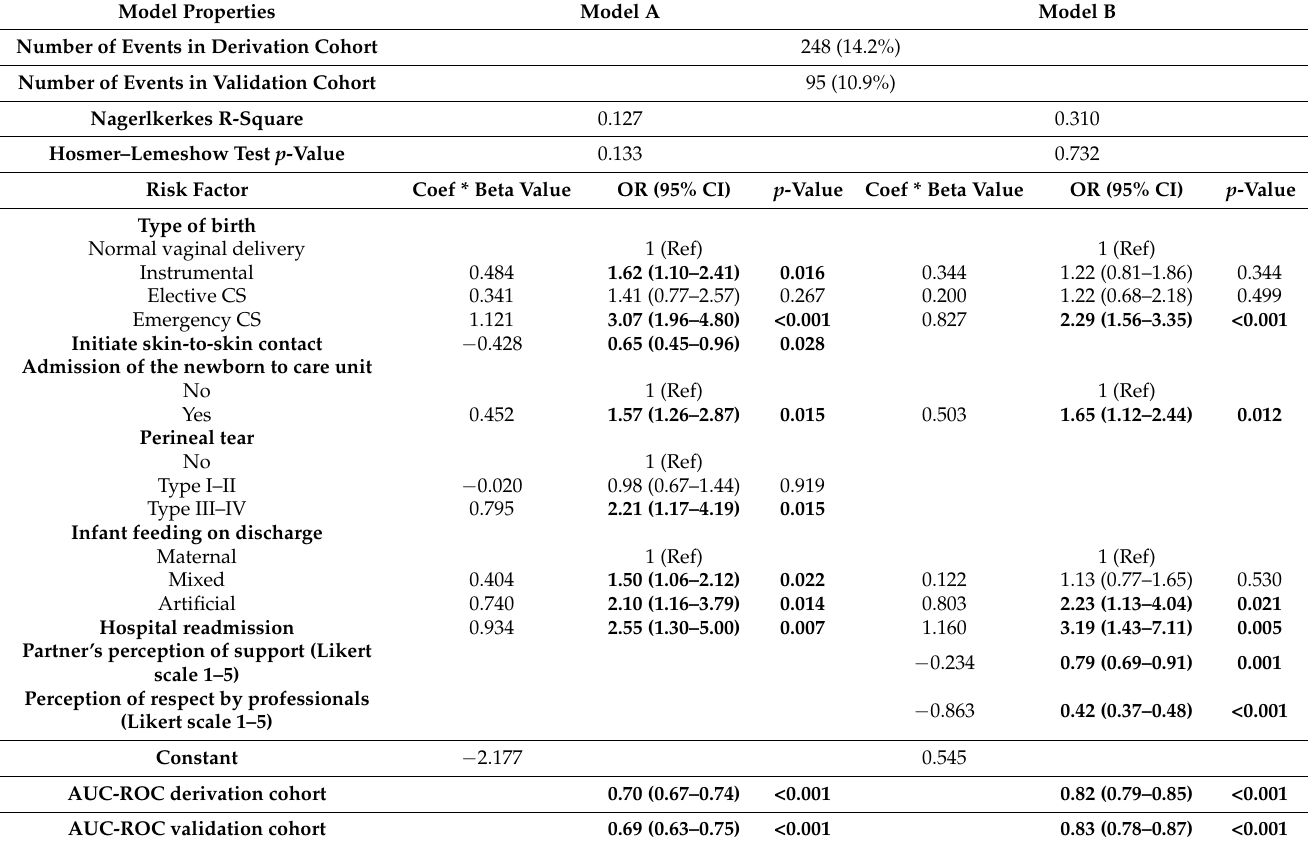
Table 2. Predictive models of PTSD risk during the